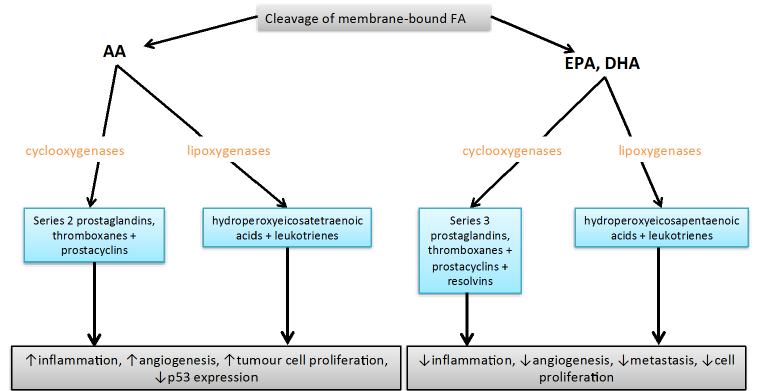
Figure 2. Effects of eicosanoids derived from AA and EPA/DHA. Cyclooxygenases and lipoxygenases act on AA, EPA and DHA to synthesise a range of different eicosanoids during an inflammatory response. AA-derived eicosanoids often generate pro-inflammatory compounds that enhance tumour growth, while EPA/DHA-derived eicosanoids often have anti-inflammatory properties and inhibit tumour growth [21,22]. FA: fatty acids; AA: arachidonic acid; EPA: eicosapentanoic acid; DHA: docosahexanoic acid.